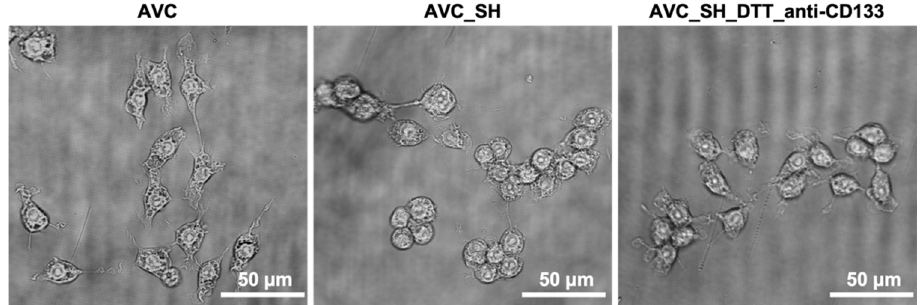
Figure 9. Bright-field microscopy of the macrophages on the functionalized surface with AVC, with AVC after mercaptosilanization and with AVC after mercaptosilanization, reduction and anti-CD133 immobilization.